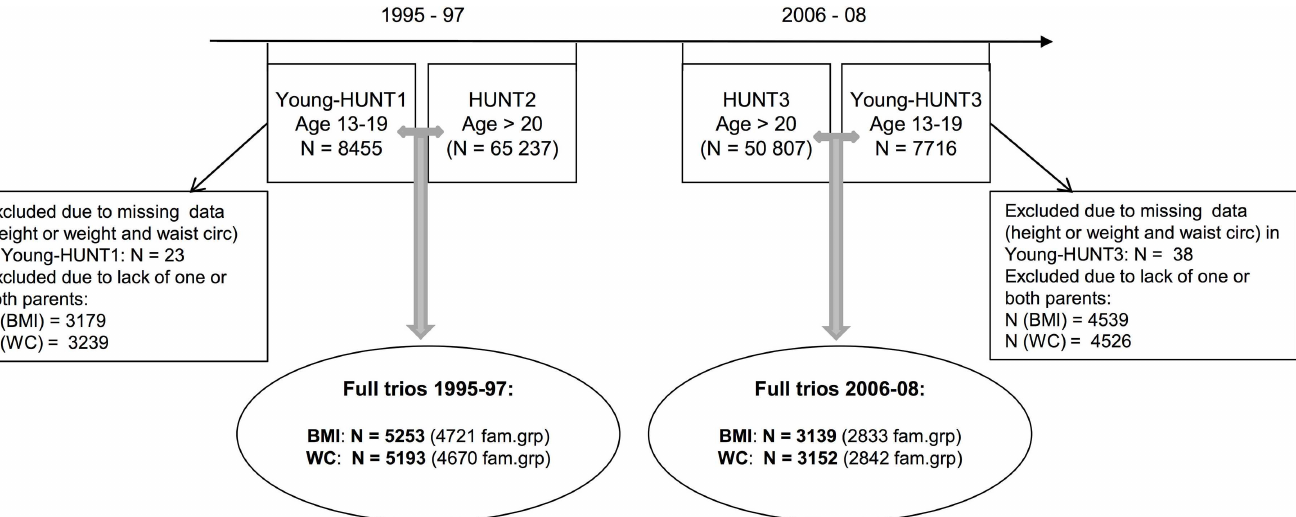
PLOS ONE | DOI:10.1371/journal.pone.0166585 November16,